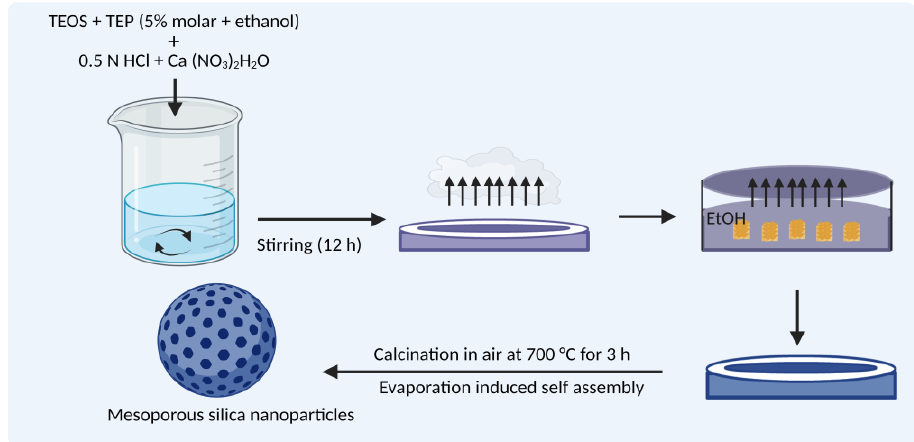
Figure 6. Formation of MSN by the evaporation-induced self-assembly method. (Figure created using BioRender.com; accessed on 2 December 2022).